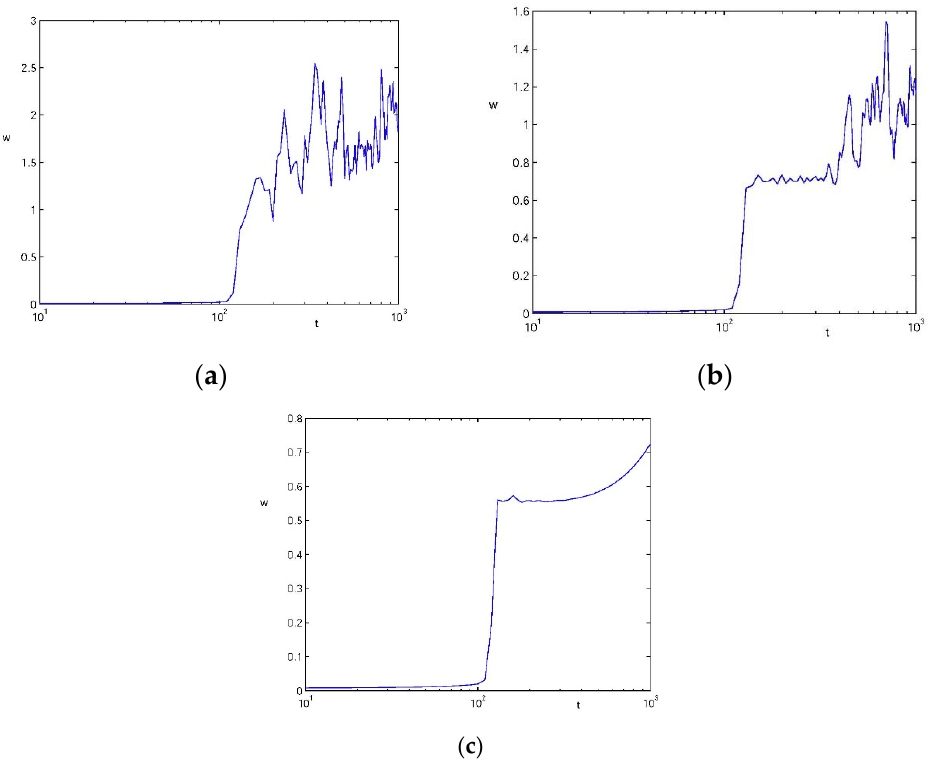
Figure 3. Surface width w ( t ) vs. time t for t = 1000 ( a ) r = 0.01 ( b ) r = 0.5 ( c ) r = 1.